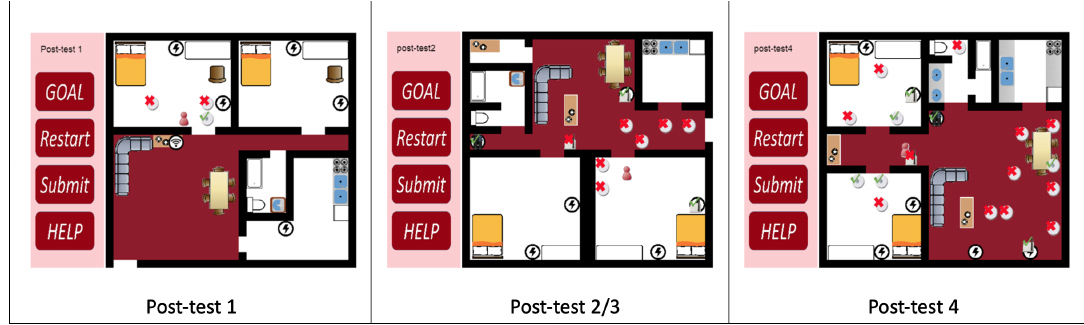
Figure 8. Examples of post-tests.